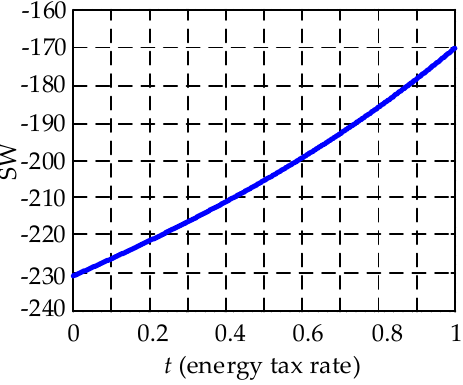
Figure 5. Social welfare vs. the energy tax rate.